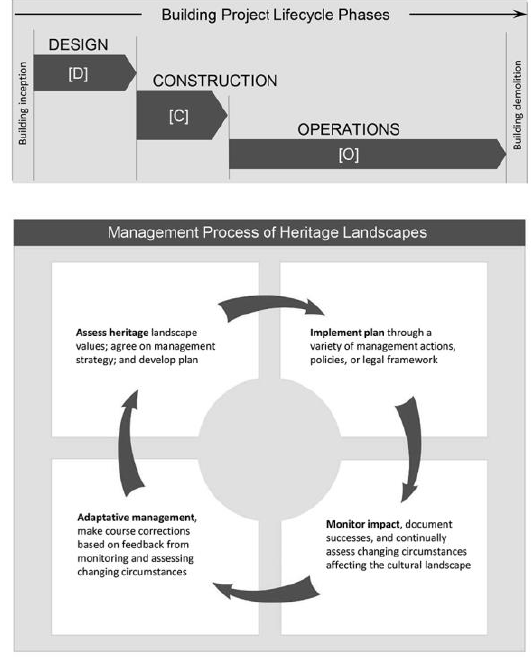
Figure 4. Building project lifecycle phases and